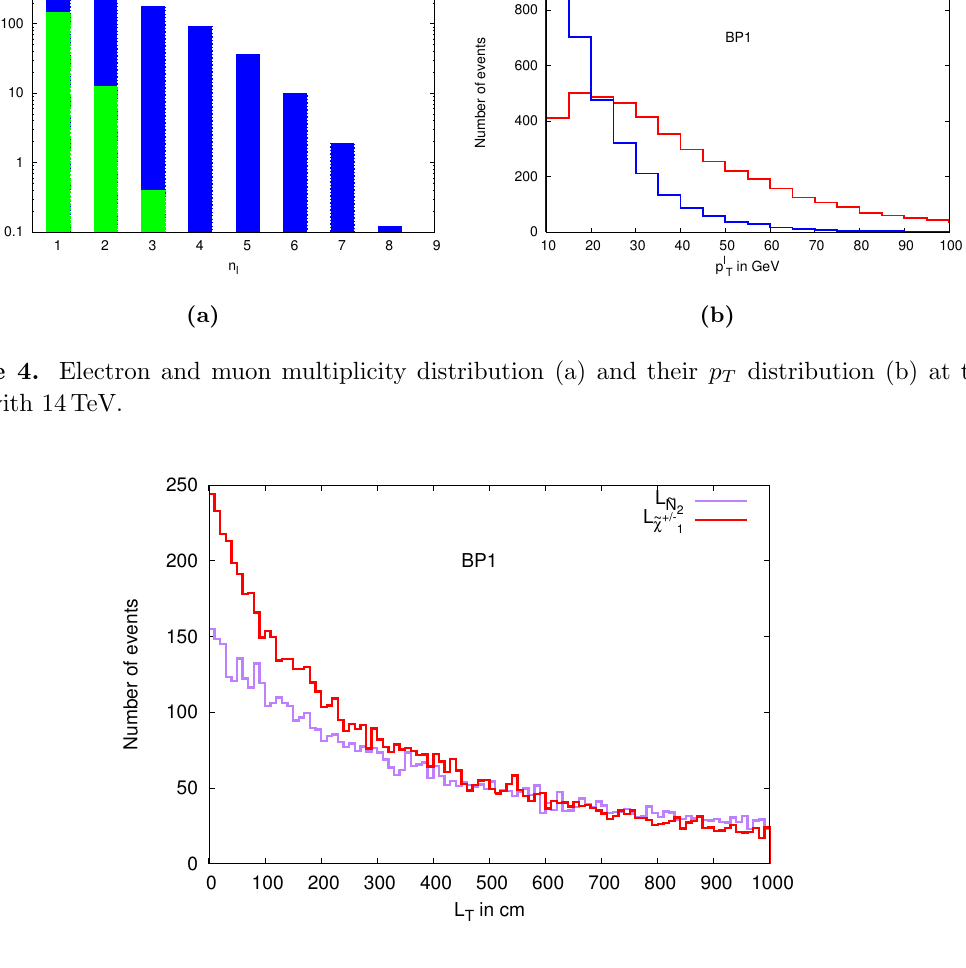
at the LHC with 14 1